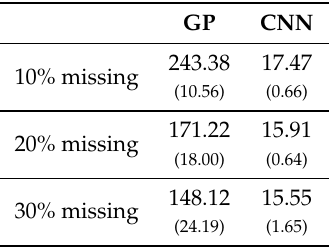
Table 2. Average and standard deviation (in parenthesis) of the 10-fold execution time in seconds per percentage of missing